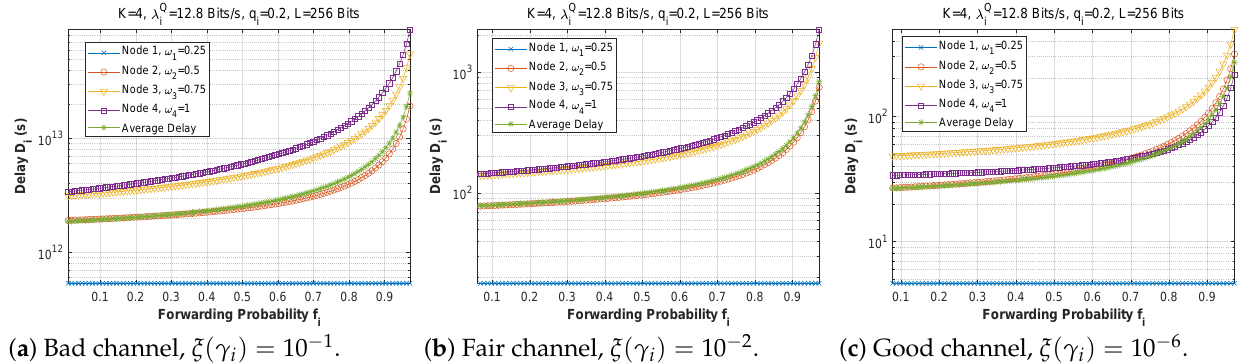
Figure 7. Setting 2: The delay experienced at each mobile device when varying the forwarding probability with the bit error rate ξ ( γ i ) .